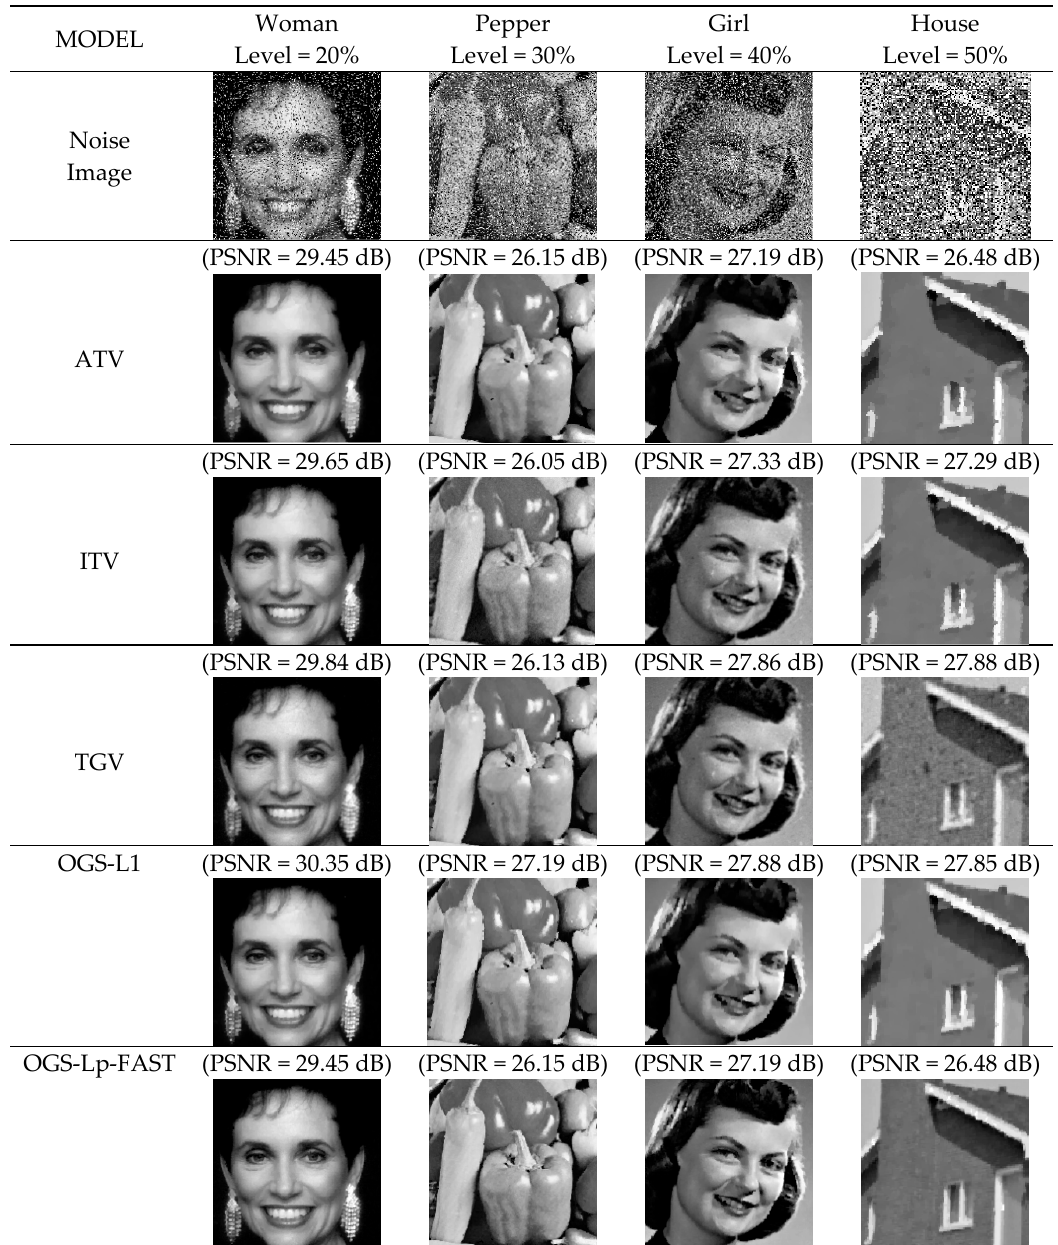
Figure 6. Comparison of image details recovered by our proposed models and other models. The test images (“Woman”, “Pepper”, ”Girl”, and ”House”) are corrupted by 20~50% impulse noise, respectively.